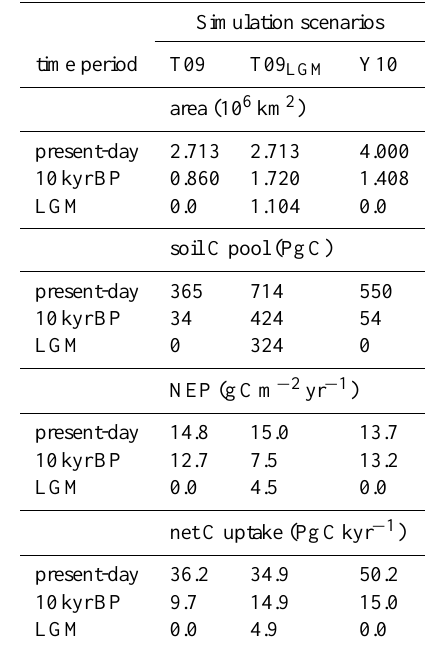
Table 3. Northern peatland area, peatland soil C (both acrotelm and catotelm), peatland NEP, and net C uptake rate in northern peatlands. Values represent 50yr averages of model outputs: present-day=1950–2000AD; 10kyrBP=10.025–9.975kyrBP; and LGM=21.0–20.95kyrBP. Values for the LGM denote equilib- rium values after spinup. Scenarios T09 and T09 LGM use scaled present-day peatland areas by Tarnocai et al. (2009) and Y10 by Yu et al. (2010). T09 LGM has no restriction on peat initiation and peatland areas during the